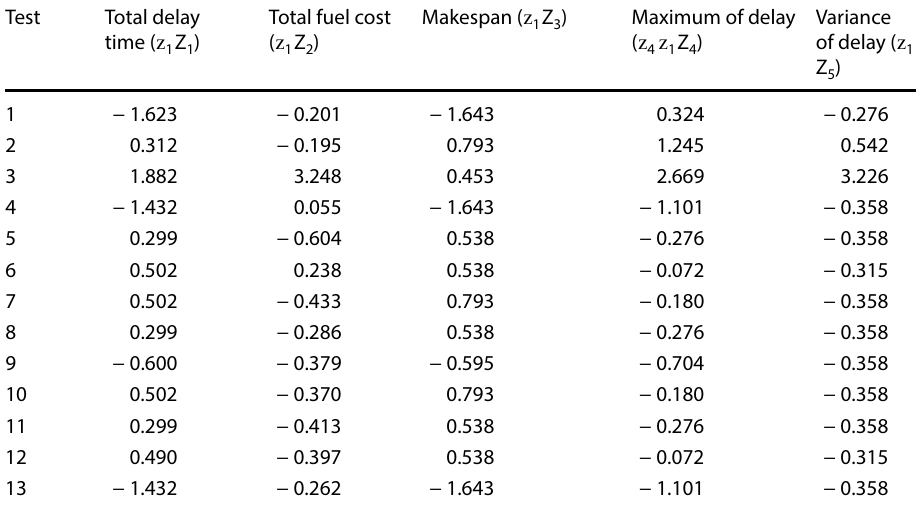
Table 7 the normalized results of Table